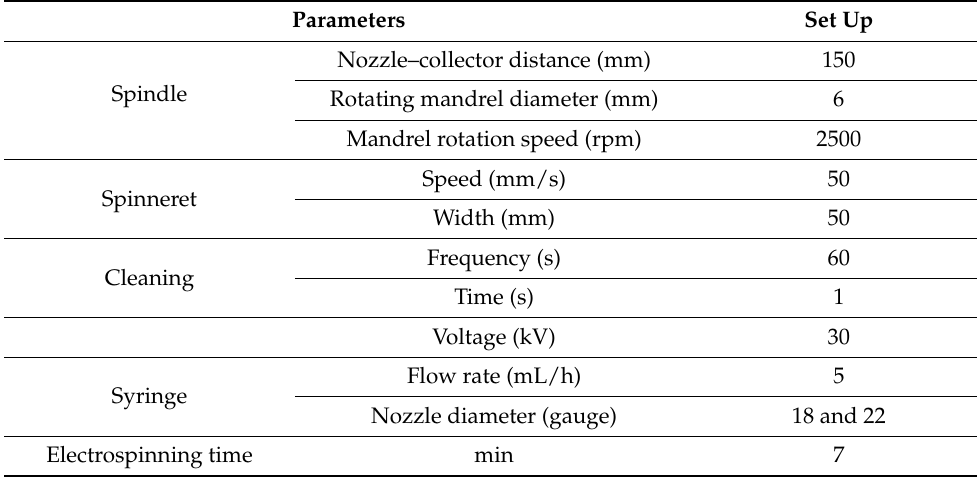
Table 1. Electrospinning process